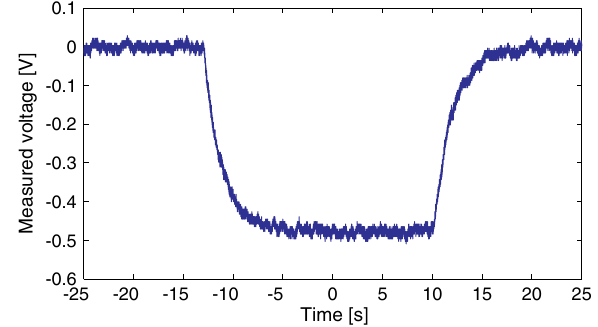
FIG. 18. Response of the Faraday cup to a chopped beam corresponding to about 500 fA registered at 10 12 V = A